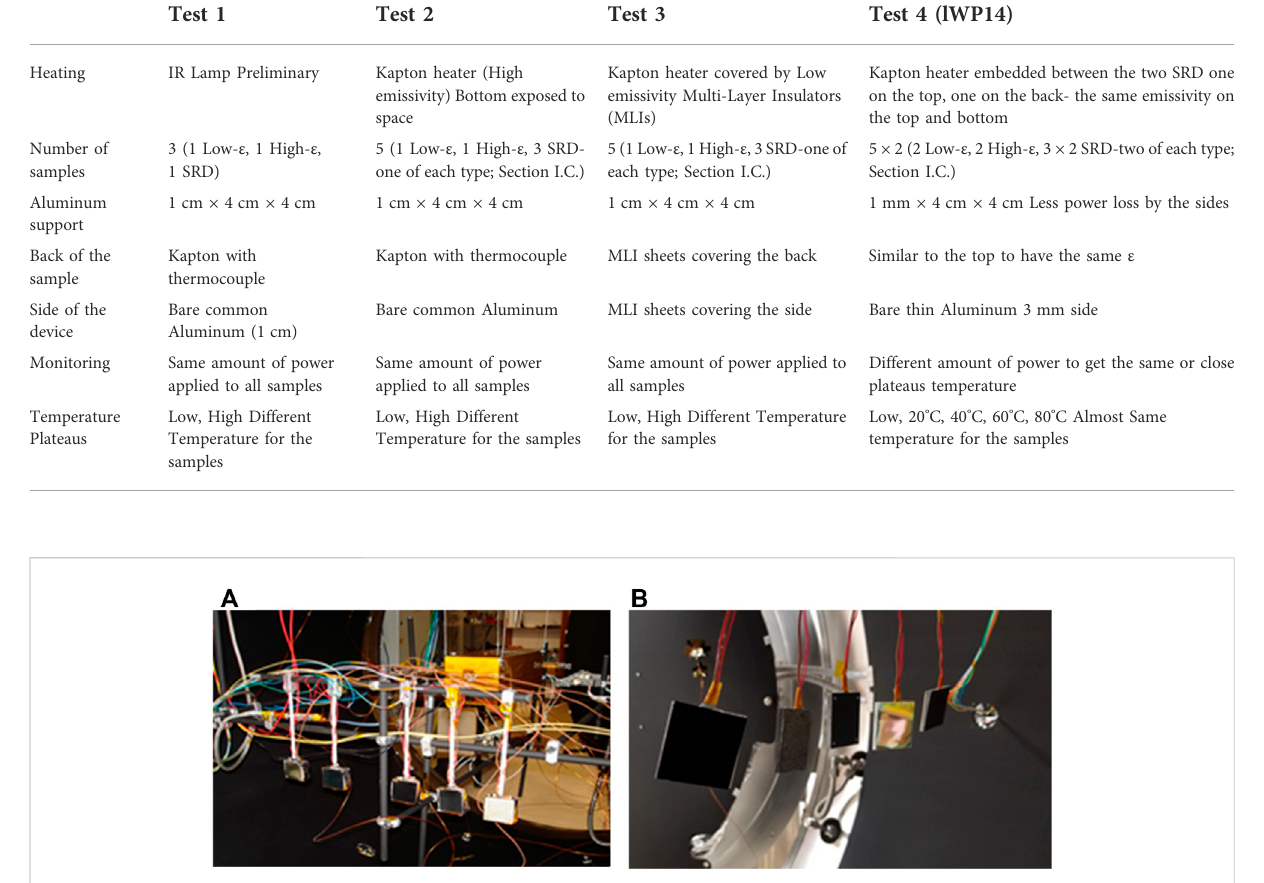
FIGURE 8 (A) Pictureofthe fi vesamplesattachedinsideDTVACinTest3 (B) Pictureof fi vedouble-sided SRDsamplesfortest4,thetopandbacksurfaces were similar samples to increase the